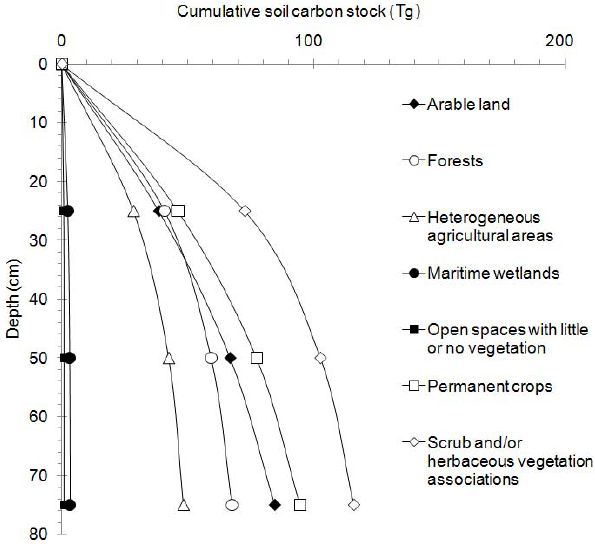
Fig. 5. Cumulative soil organic carbon stock in depth for each land use